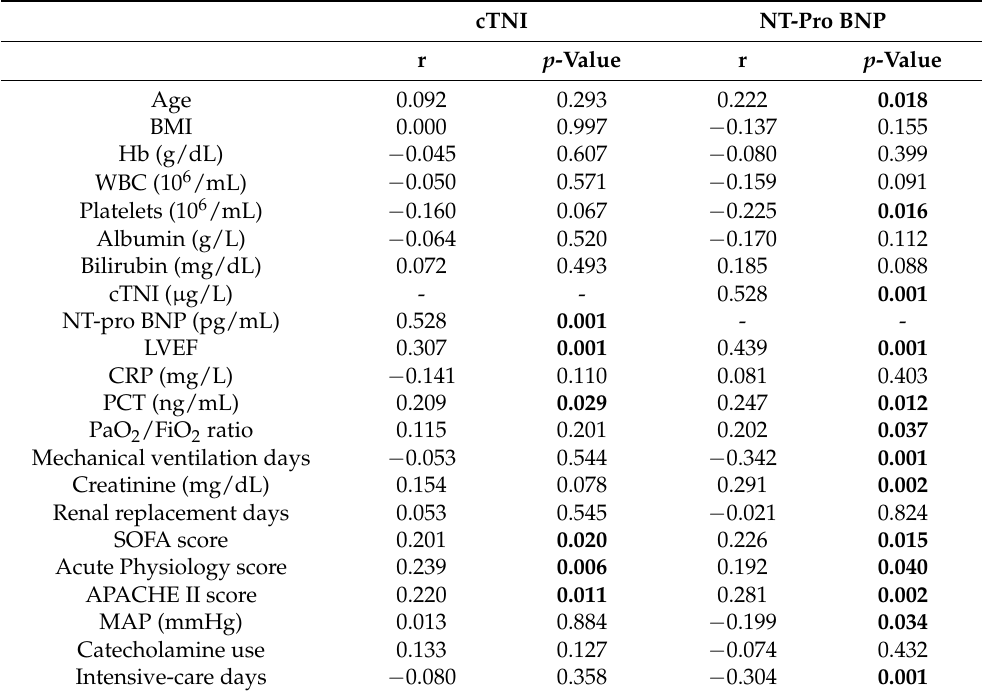
Table 3. Univariate correlations of TNI and BNP with laboratory and clinical parameters in all patients ( n = 162) on day 1.